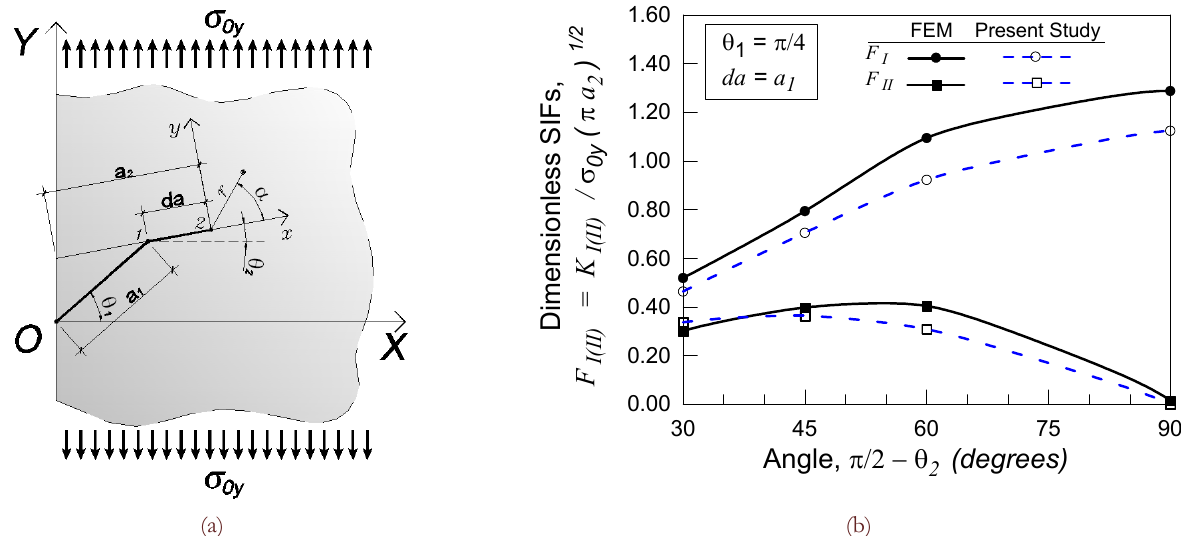
Figure 7: (a) Edge-cracked plane. (b) SIFs obtained from the simplified method (present study, dashed line) and a FE analysis (continuous line) for a two-segment